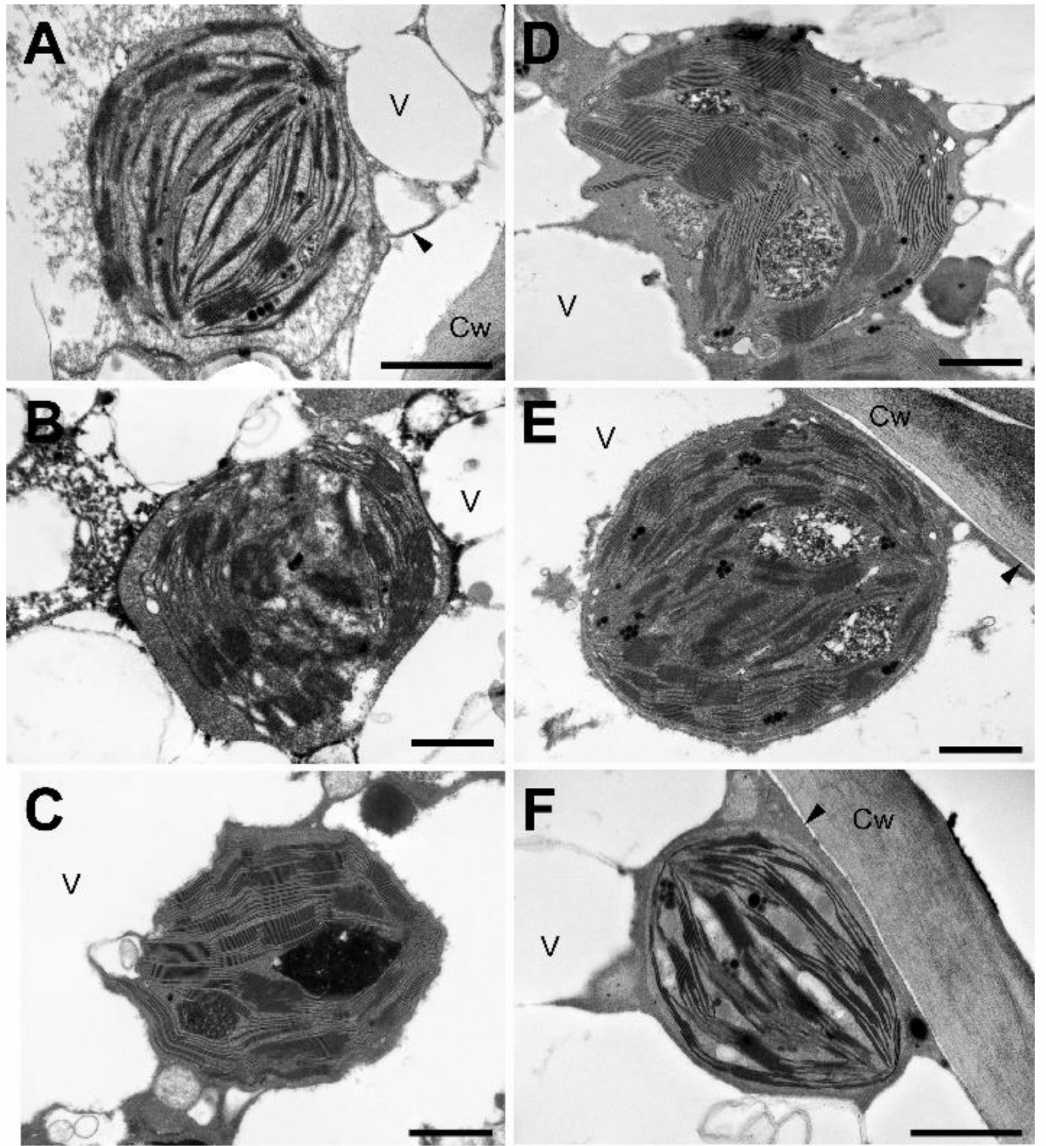
Figure 3. Chloroplast ultrastructure during recovery from drought-induced desiccation (RAD) of H. rhodopensis leaves. ( A ): 0 h, ( B ): 9 h, ( C ): 15 h, ( D ): 18 h, ( E ): 24 h, and ( F ): 30 h after rehydration. Arrowhead: plasma membrane; Cw: cell wall; V: vacuole. Scale bar is equal to 1 µ